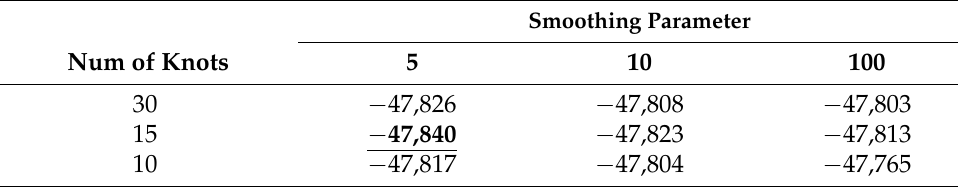
Table 20. DIC for Weibull distribution (4 January 2016, JAL, Tokyo, Japan).